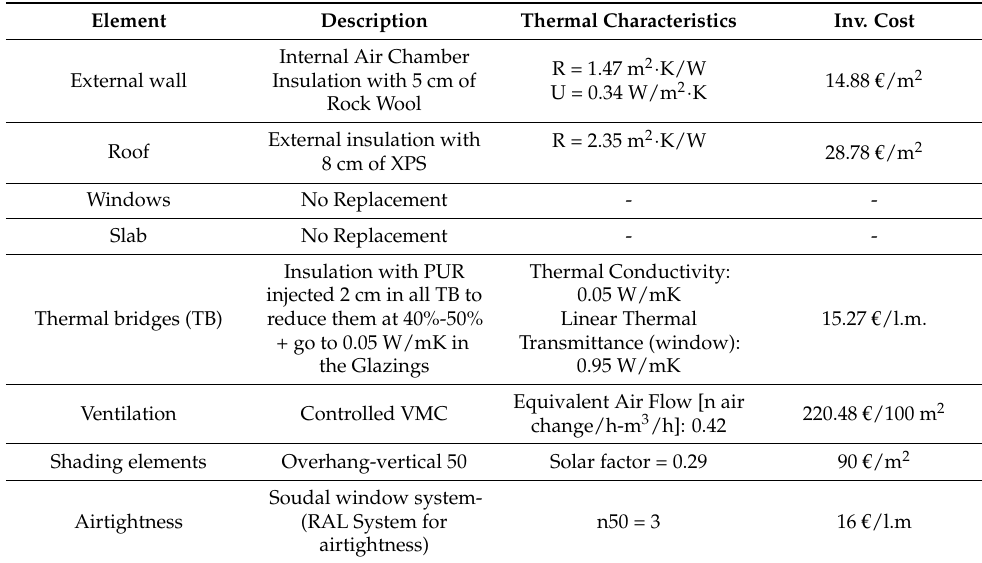
Table A12. POS13: Renovation measures of solution 8; and POS13s: Renovation measures of solution